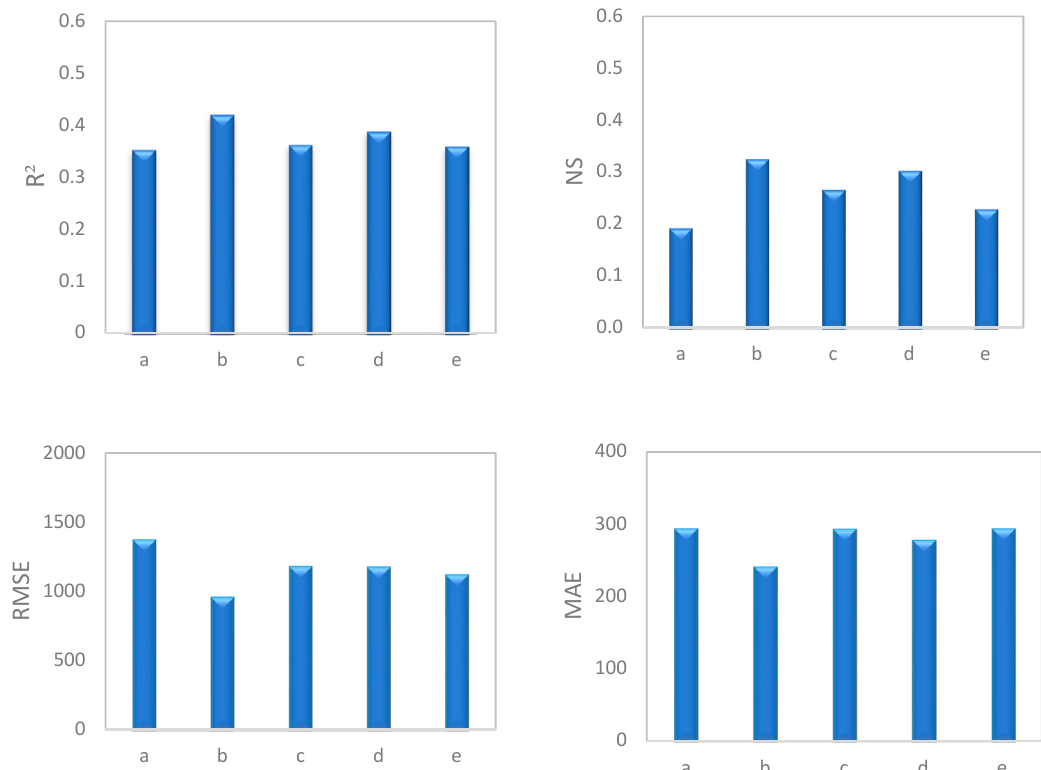
Figure 4. Comparison of the average performance indices (RMSE, MAE, NS, and R 2 ) for the SRC model with different methods of data separation.